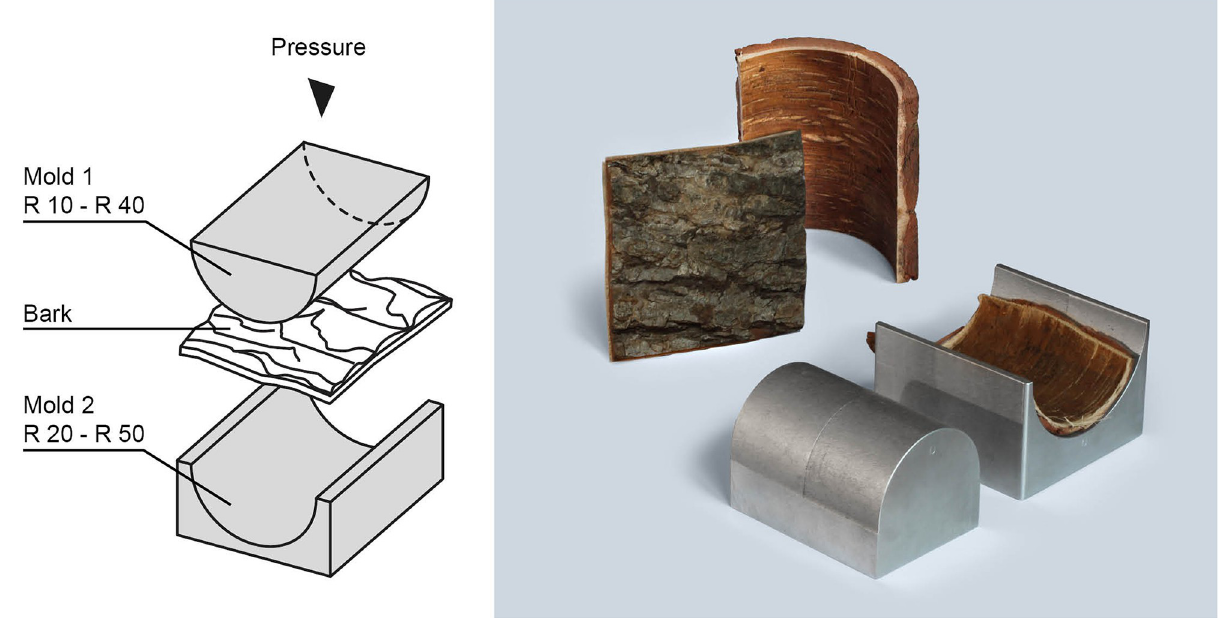
Fig 9. Illustration of the pressing process (left). Produced curves with a radius 50mm and a random thickness caused by the natural structure of the pressed (oak) bark piece (right).